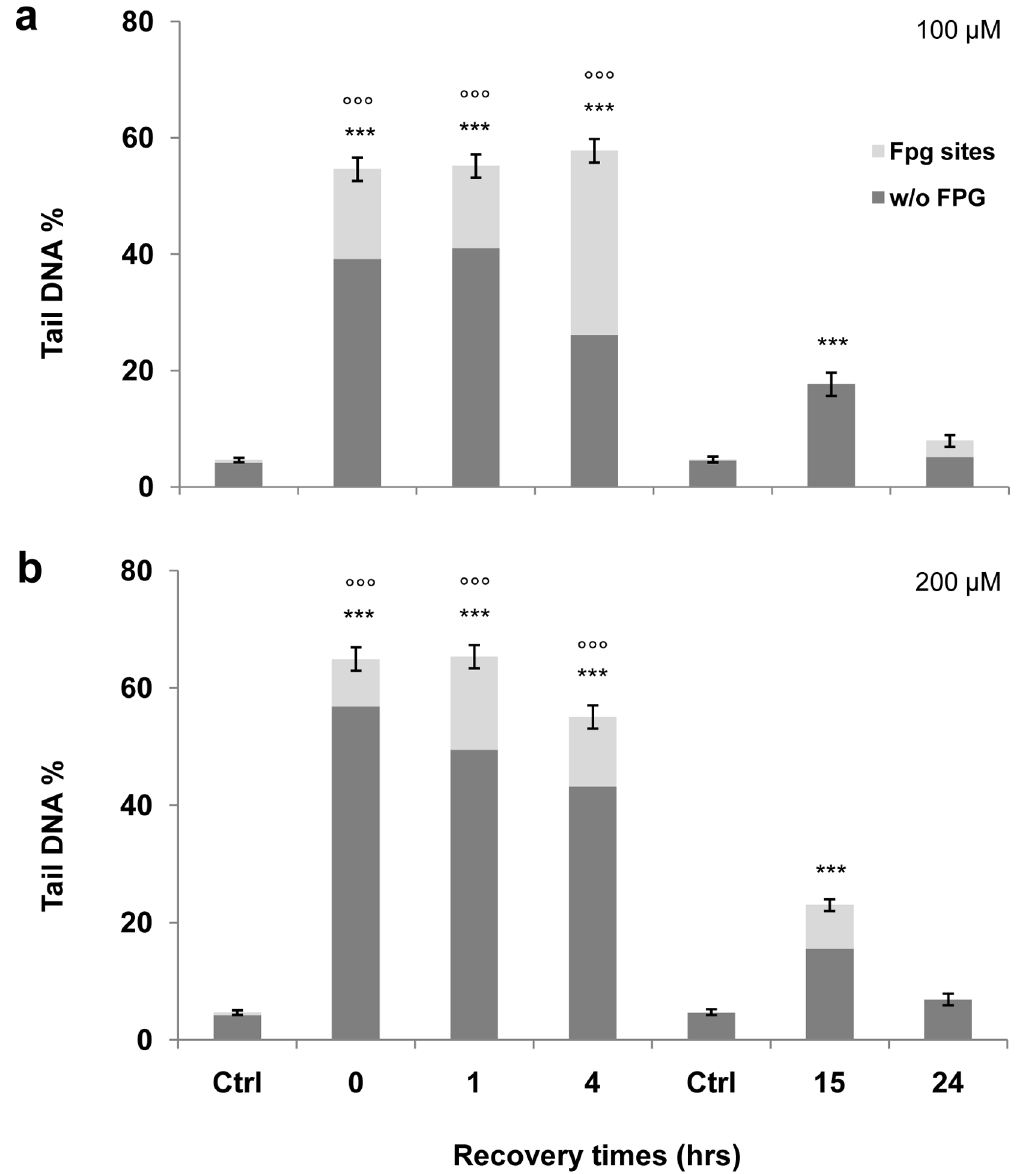
Figure 1. Standard and FPG-modified alkaline comet assay. Standard and FPG-modified versions of the comet assay have been used to evaluate the fold increase in genomic damage induced by hydrogen peroxide with respect to the control value. The net cleavage sites generated by FPG activity were calculated subtracting the value of total DNA damage yielded by the samples not treated with the enzyme from the DNA damage value obtained from samples treated with the enzyme. The value of this subtraction is shown in the graph as a light grey portion labelled ‘‘FPG sites.’’ To assess any changes in Tail DNA values, we analysed control cells immediately (time 0) and after 15 hrs treatment. All values are normalised to the control values. A significant increase (p , 0.001) is observed in the percentage of DNA damage immediately after treatment (time 0). DNA damage increases in a dose dependent manner after 1 hr treatment. We observed a time-dependent decrease of genomic damage to the control value 15 and 24 hrs after treatment. Error bars denote the standard error. (a) DNA damage induction by 100 m M H 2 O 2 . (b) DNA damage induction by 200 m M H 2 O 2 . ***p , 0.001; **p , 0.01; *p , 0.05. Treated cells plus FPG versus controls plus FPG by Mann–Whitney U test. uuu p , 0.001; uu p , 0.01; u p , 0.05 Treated cells plus FPG versus cells of the same experimental point without FPG by Mann–Whitney U